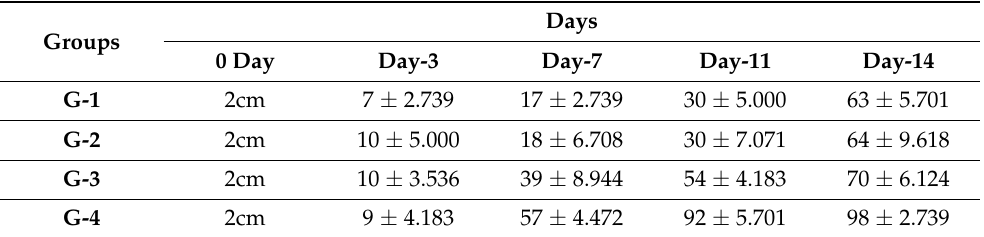
Table 4. The percentage of mean wound recovery in wound area within 14 days of wounding in Group 1 (infected and untreated control), Group 2 (infected and untreated control), Group 3 (infected and treated with imipenem), and Group 4 (infected and treated with ZnO-NPs). Days Groups 0 Day Day-3 Day-7 Day-11 Day-14